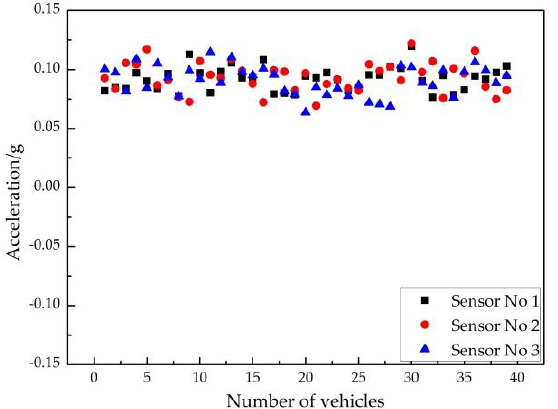
Figure 11. Scatter plot of peak acceleration of Segment 1 in the current monitoring stage.